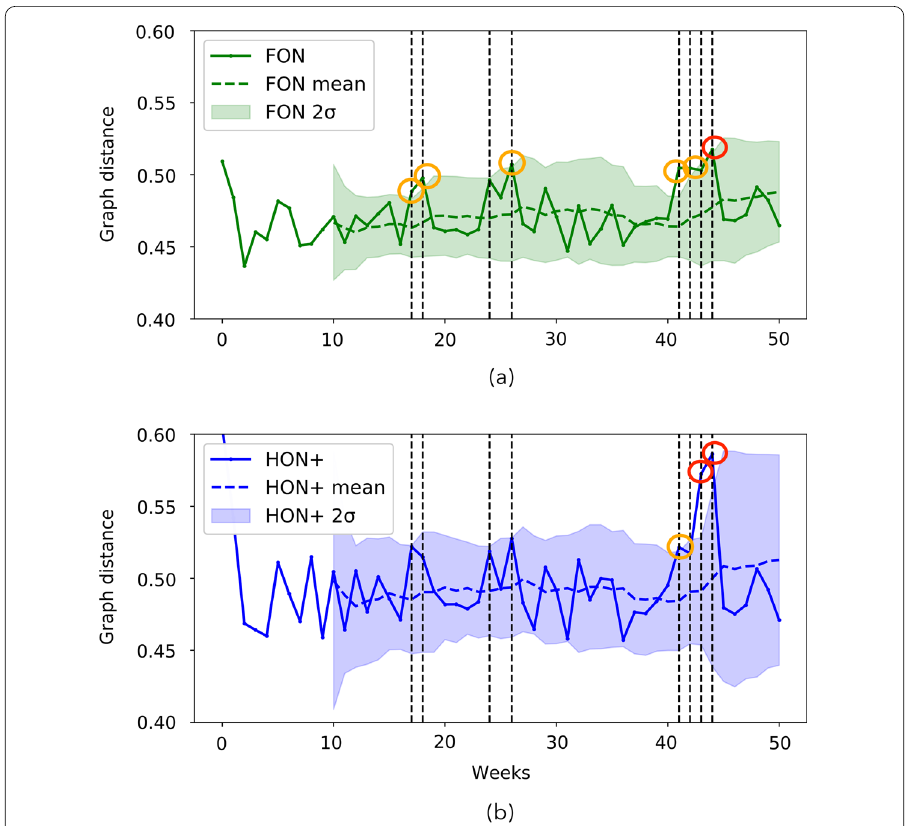
Figure 11 After addition of the noise, FON can no longer detect the true anomaly signal in week 43, and detects the anomaly in week 44 with a graph distance that is very close to the 2 σ threshold. Furthermore, FON shows false positives in week 17, 18, 26, 41, 42 ( a ). HON+ detects the anomaly in week 43 and 44 with one false positive after addtion of the noice ( b ). Correct anomalies are marked as red and false anomalies are marked as